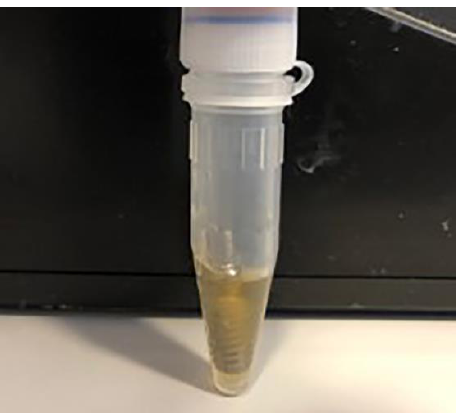
Figure 7. Implant assemblies immersed in a solution contaminated with S. aureus and C. albicans, in Eppendorf tubes. Eppendorf